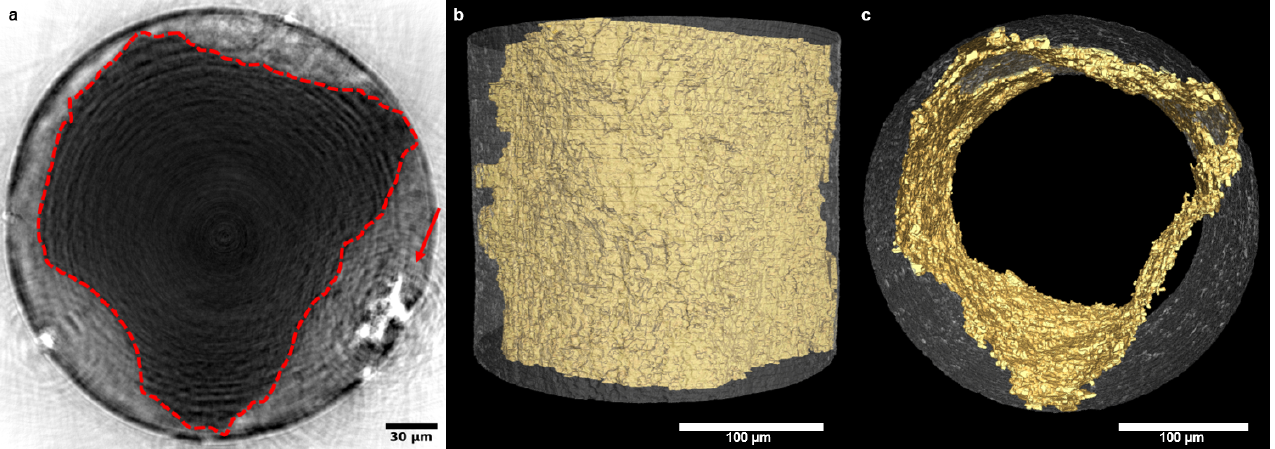
Figure 3. ( a ) Slice through tomographic reconstruction of a solution annealed Mg-2Ag wire after 7 days of degradation. The degradation layer can clearly be distinguished from the residual metal (dashed red outline). The red arrow indicates a cluster of strongly phase shifting materials within the sample, potentially Ag precipitates, and resulting phase wrapping artefacts. ( b , c ) The 3D surface rendering of the residual metal of the degraded wire shown in ( a ) obtained after segmentation and superimposed with a semi-transparent surface rendering of a non-degraded wire in two orthogonal